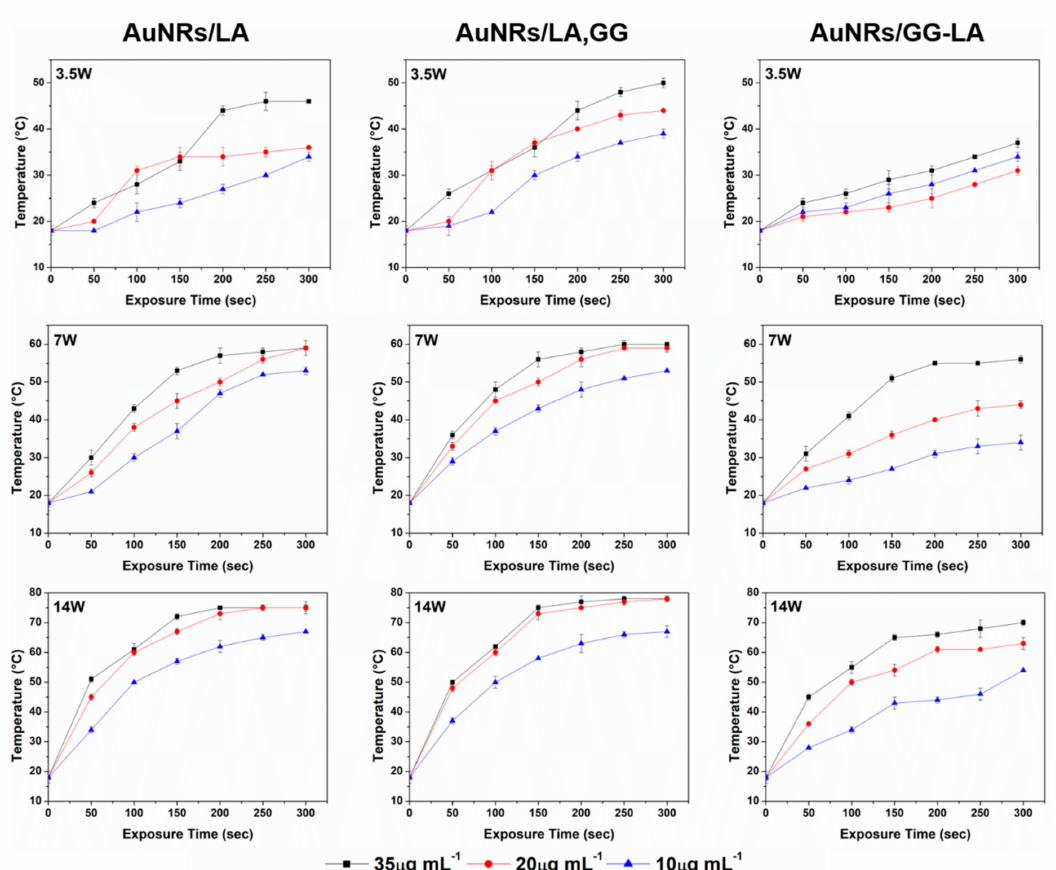
Figure 5. Time-dependent thermal rising of AuNRs / LA(left), AuNRs / LA,GG (center), and AuNRs / GG-LA (right) aqueous dispersions, at concentrations of 35, 20, and 10 µ g · mL − 1 , during 300 s of 810 nm laser treatment with power of 3.5 × 10 − 3 (first line), 7 × 10 − 3 (second line), and 14 × 10 − 3 W / mm 3 (third